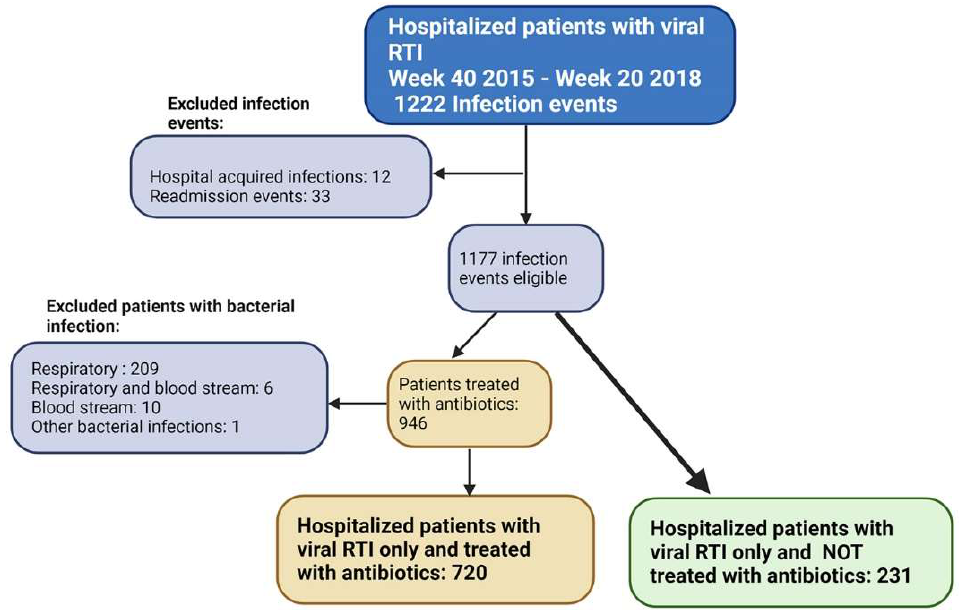
Figure 1. Flowchart showing the selection of the study population. Table 1. Demographic data, medical status at admission and clinical outcome in 951 hospitalizations due to viral RTIs according to antibiotic treatment